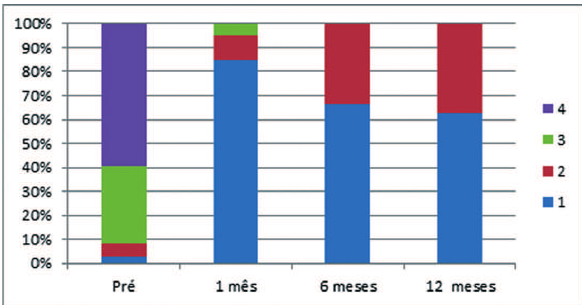
Fig. 3 – Evolução da classe funcional